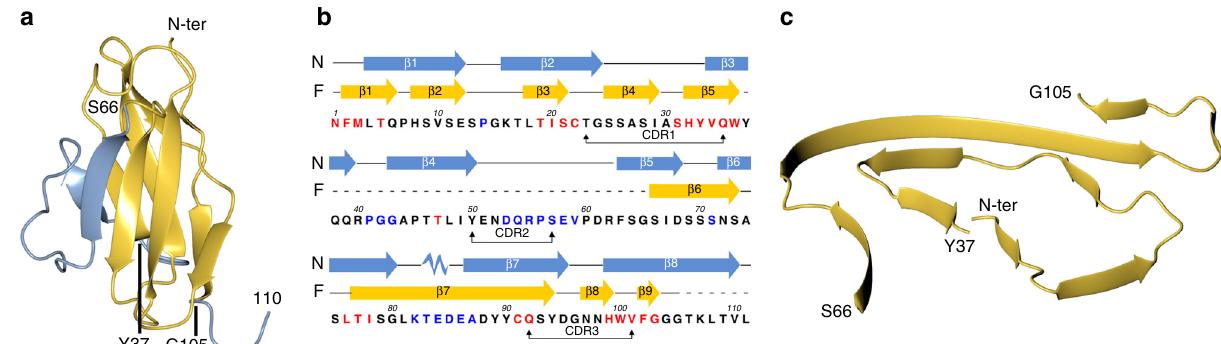
Fig. 4 Comparison of native and fi bril AL55 structures. a Ribbon representation of AL55 V l domain native structure (model). The ordered and disordered regions in the structure of the fi bril core are in yellow and blue, respectively. b Sequence of AL55 V l domain: scheme of the secondary structure elements of the natively folded LC (N, blue), and of the fi bril assembly (F, yellow), respectively; dashed lines correspond to residues not-modeled in the EM density. Residues are colored according to their intrinsic aggregation propensities, as de fi ned by CamSol 27 (high, in red; low, in black; very low in blue). c Ribbon representation of the AL55 V l domain fi bril